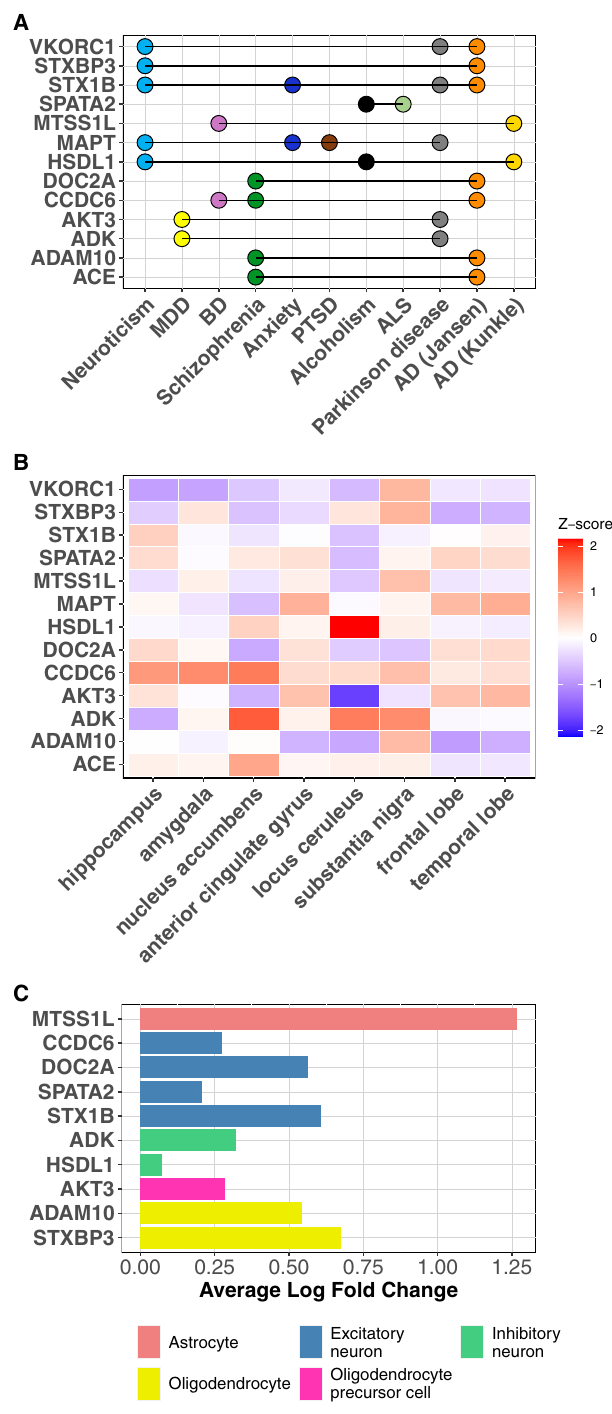
Fig. 5 | Expression in different brain regions and cell types for the 13 causal proteins shared between the psychiatric and neurodegenerative diseases. A List of the 13 proteins mutually causal in both the psychiatric and neurodegen- erative diseases. B Expression of the 13 shared causal proteins in different brain regions based on human brain gene expression data from the Allen Brain Atlas. Higher Z score (red) indicates higher expression, lower Z score (blue) indicates lowerexpressioninthatbrainregion. C Expressionofthe13sharedcausalproteins in different cell types based on human single-cell RNA-sequencing data. Whether thegeneexpressioninoneparticularcell-typedifferedfromitsexpressioninallthe otherfour cell types wasdetermined using the Wilcoxon rank sum test. Signi fi cant difference was de fi ned as those with Bonferroni-adjusted p value<0.05 (adjusted for all 17,775 genes). Only 10 of 13 genes were highly expressed in a particular cell type and depicted here. The other 3 genes were expressed similarly across the different cell